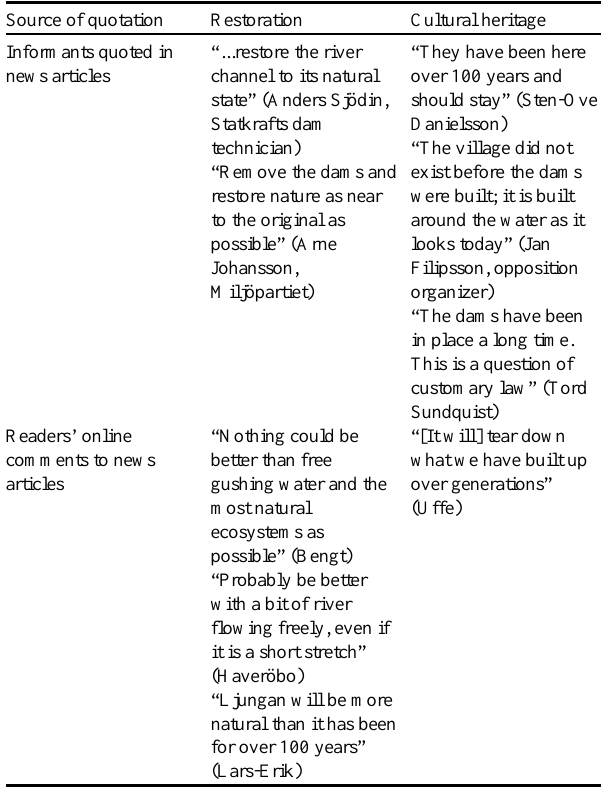
Table 4. Quotations from the Alby, Sweden, dam removal debate about restoration and cultural